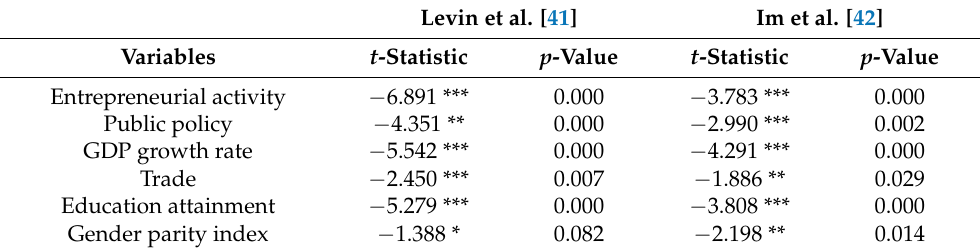
Table 3. Panel unit root